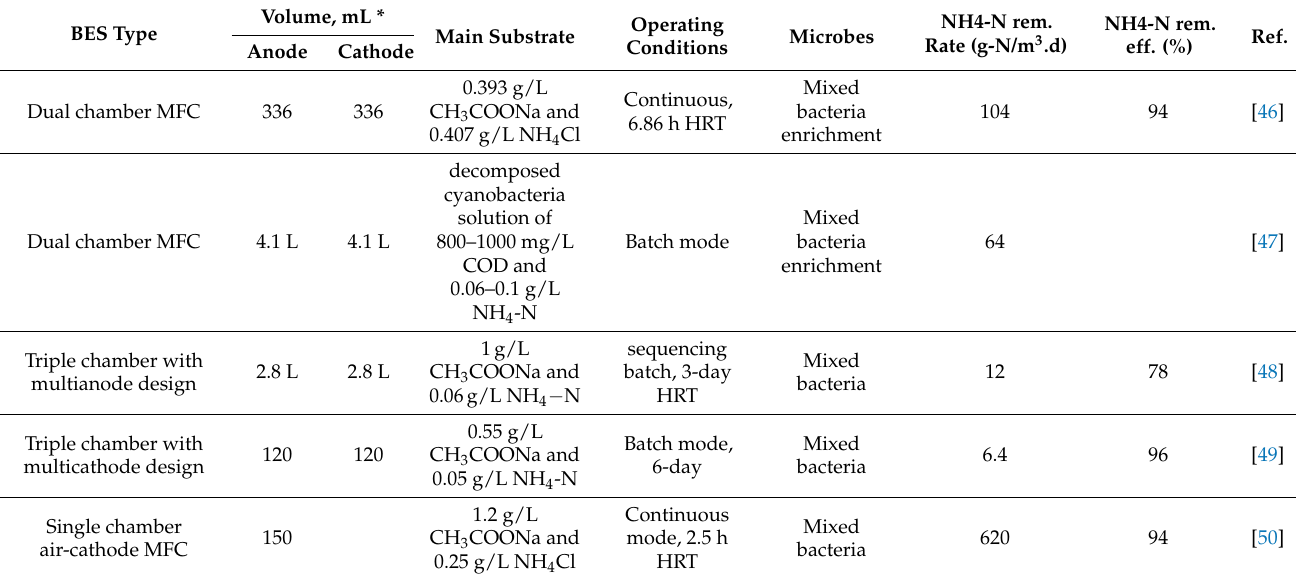
Table 2. The simultaneous nitrification and denitrification in